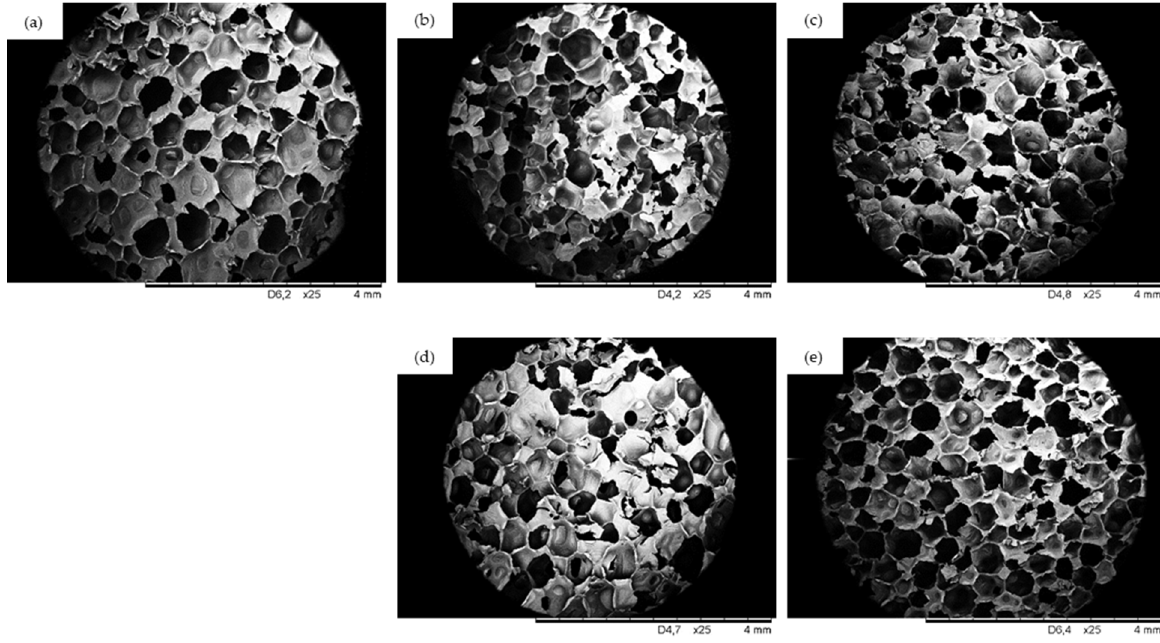
Figure 4. Cellular structure of ( a ) PUR_0, ( b ) PUR_WS, ( c ) PUR_WS/P, ( d ) PUR_WS/MMT, ( e ) PUR_WS/HL.